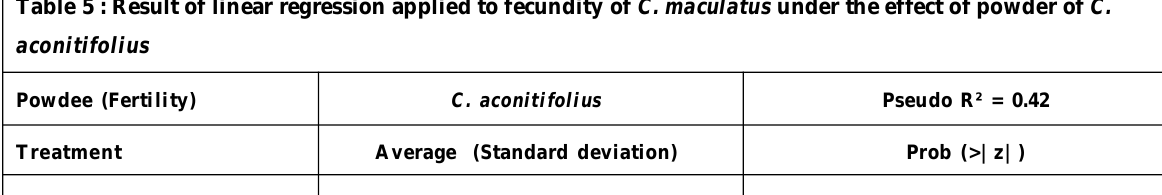
Table 5 : Result of linear regression applied to fecundity of C. maculatus under the effect of powder of